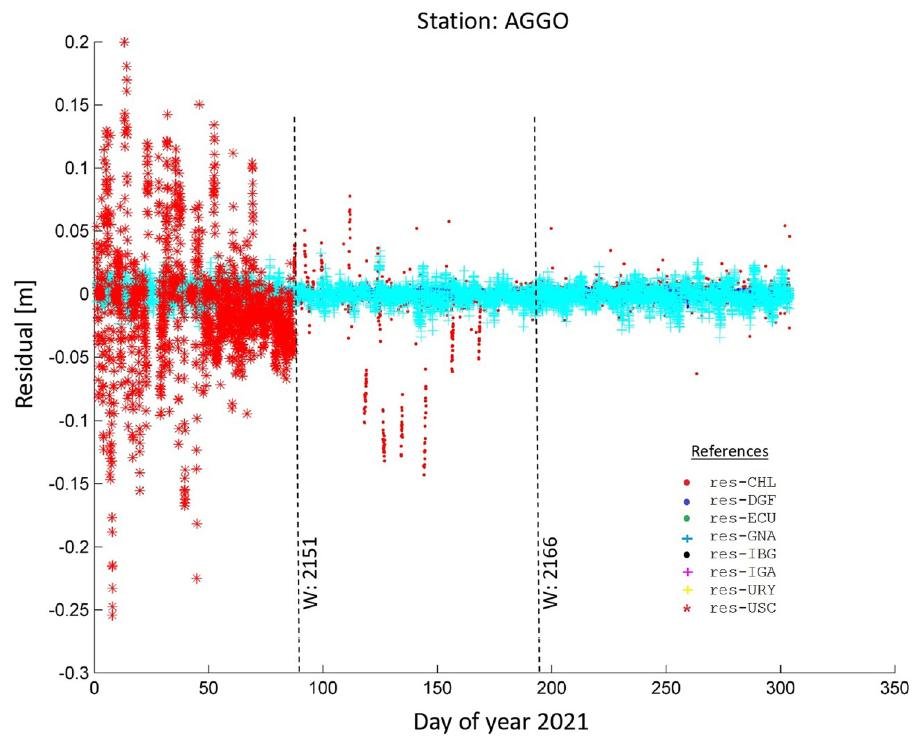
residuals in AGGO, SIRGAS - CON Station, day of year 2021. Figure 9: ZTD i tj